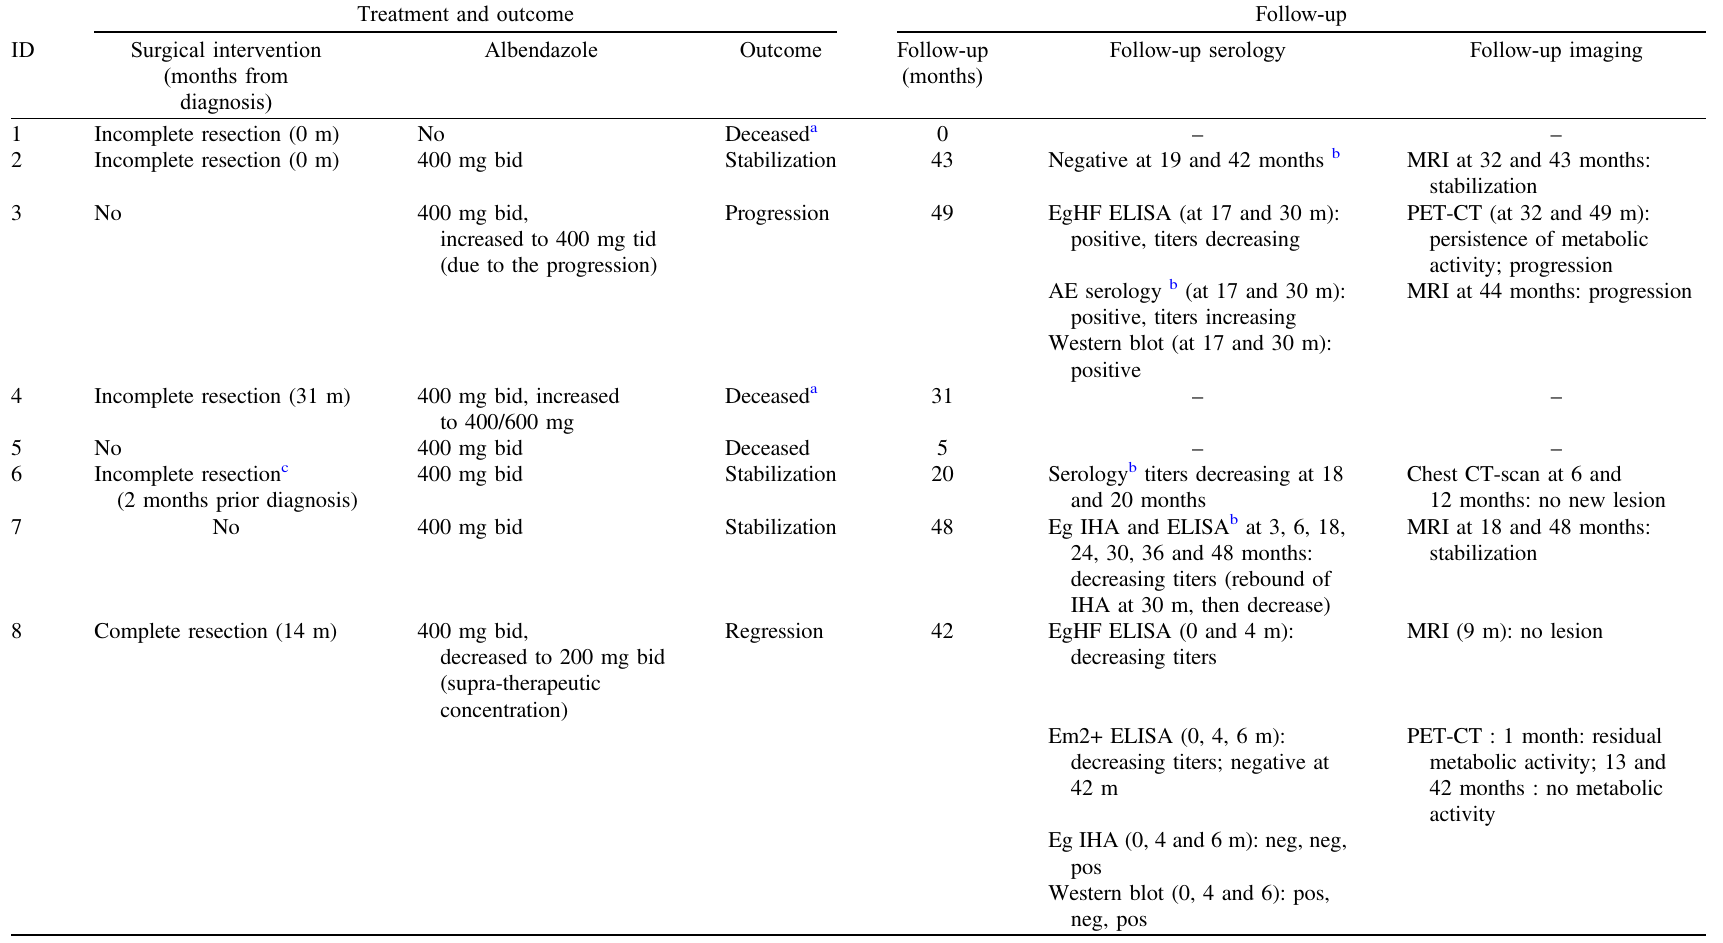
Table 3. Treatment, follow-up and outcome of AE in patients with solid organ